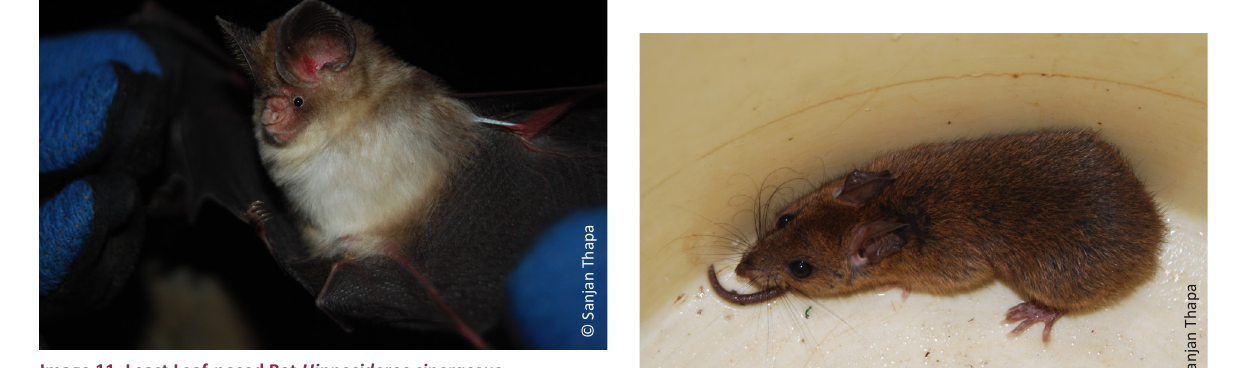
Image 11. Least Leaf-nosed Bat Hipposideros cineraceus